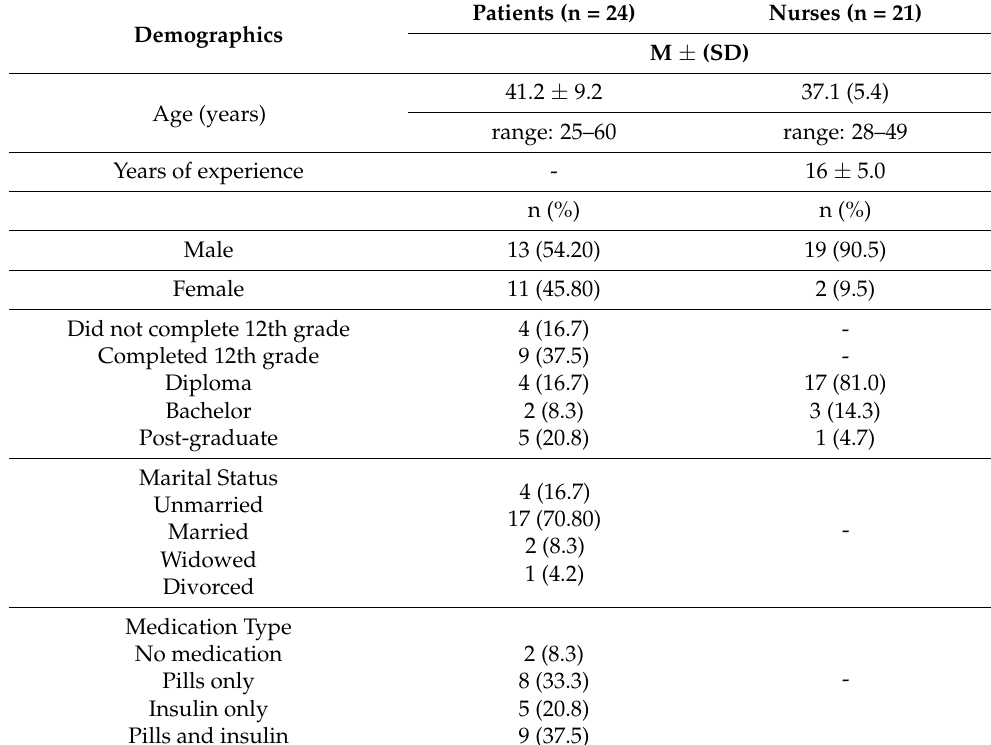
Table 1. Demographic characteristics of the interview